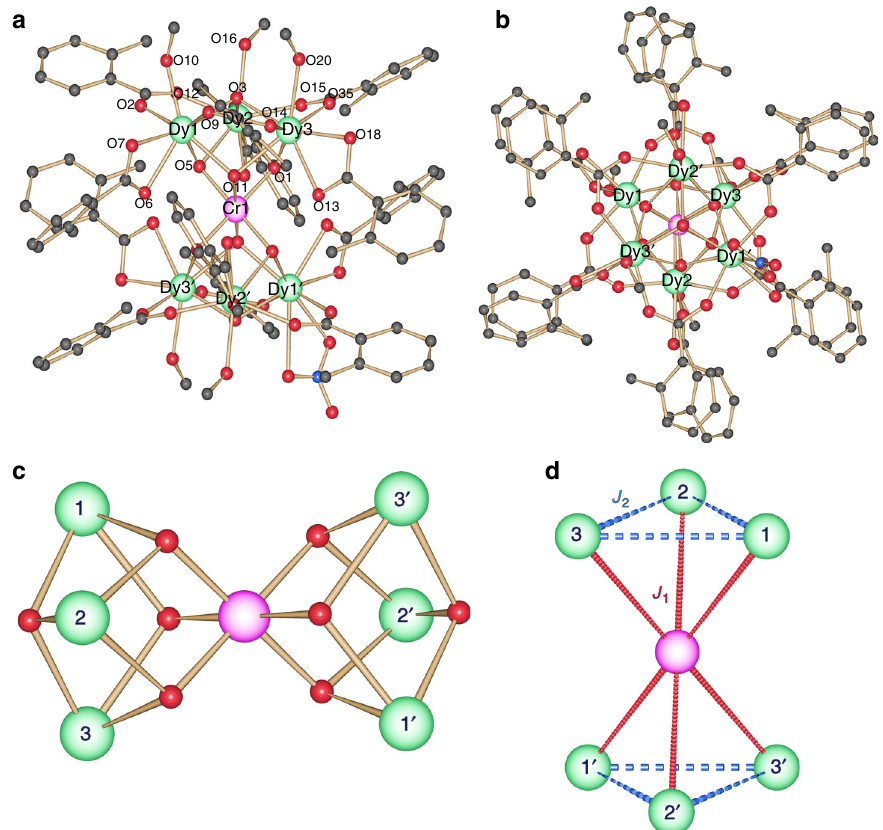
Fig. 1 Molecular structure and exchange pathways. a The molecular structure of complex 1 . The solvent and H atoms are omitted for clarity. Color scheme; Cr III , pink; Dy III , green; O, red; N, blue; C, light gray; b Top view of the molecular structure of 1 ; c Metal topology found in 1 with d magnetic exchange pathways J 1 , and J 2